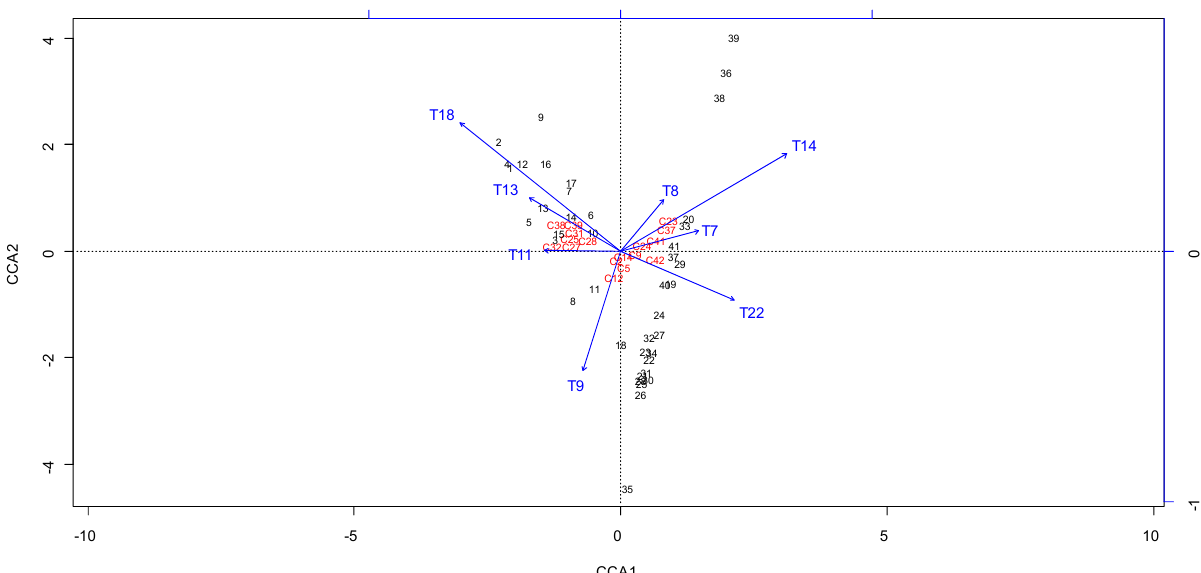
Figure 2. Correlation between melissopalynological and volatile data of “spring” honey by canonical correspondence analysis